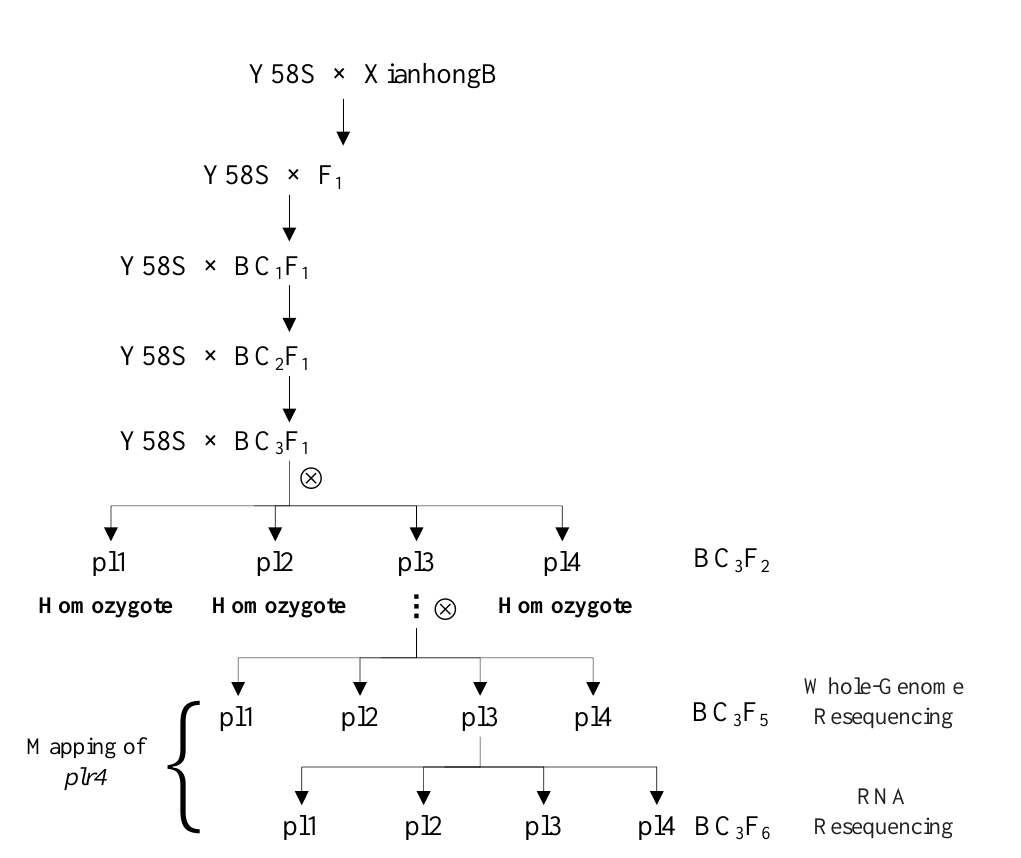
Figure 1. Construction of mapping population.